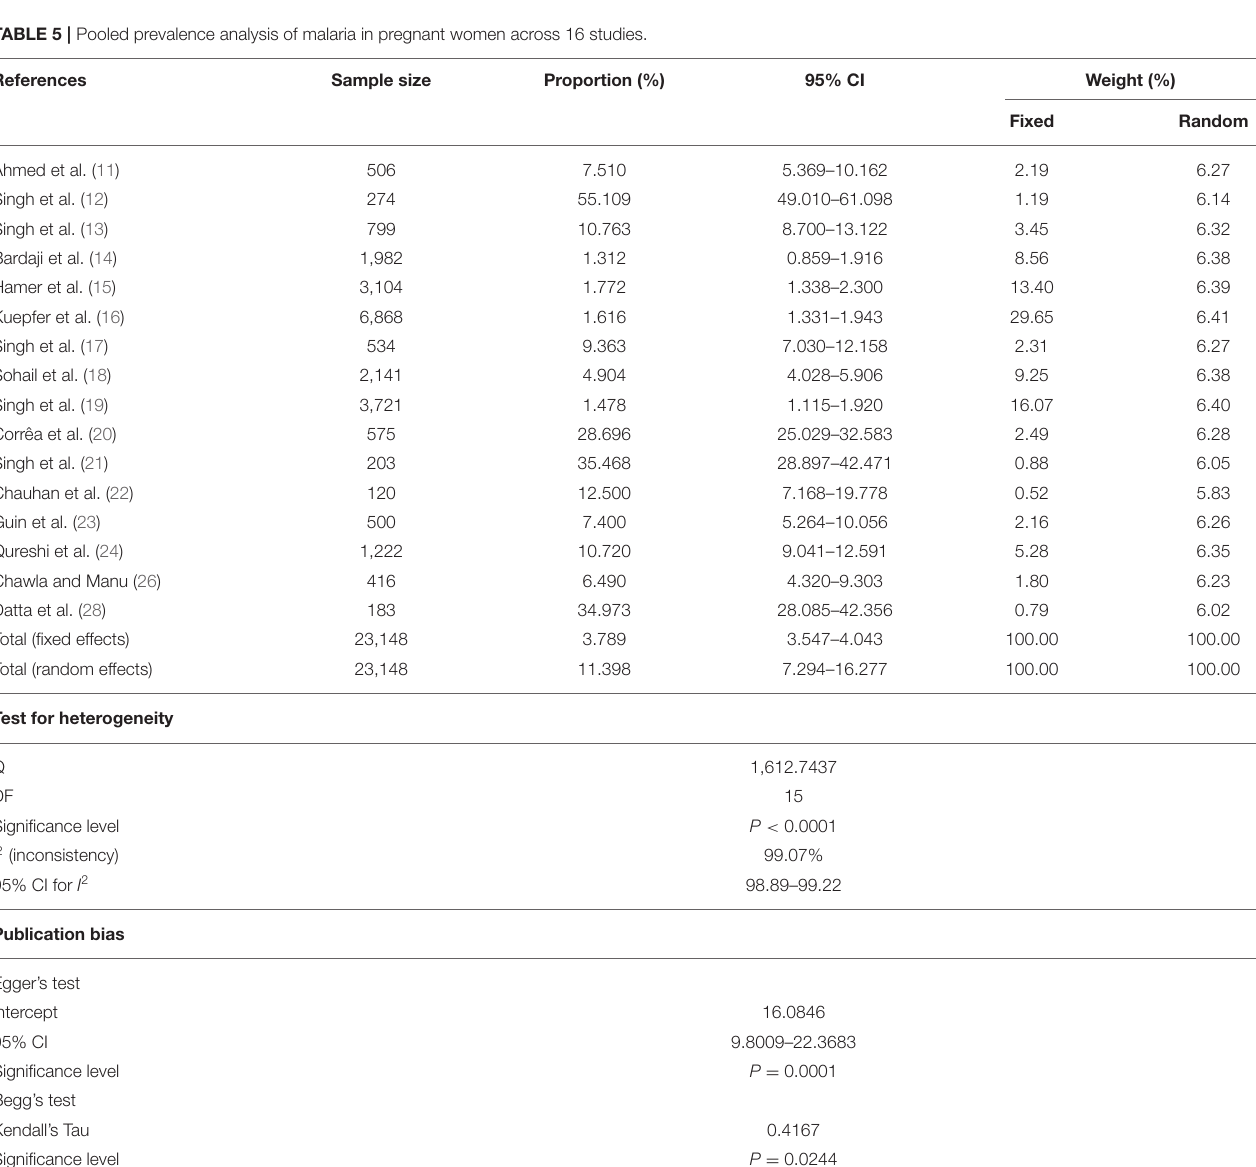
TABLE 5 | Pooled prevalence analysis of malaria in pregnant women across 16